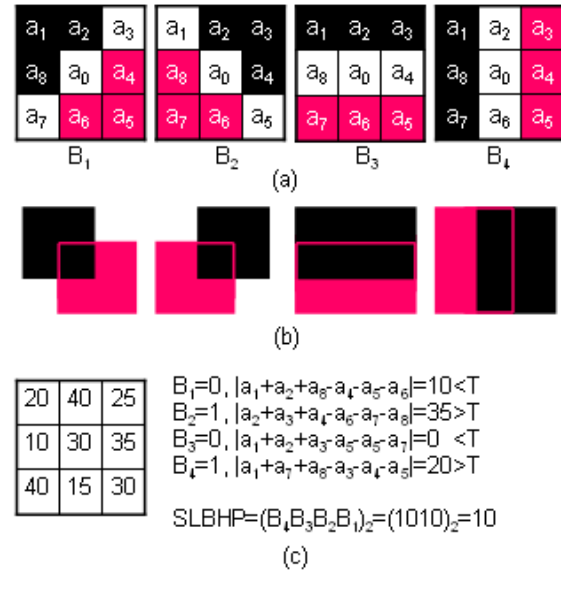
Fig. 4. An example of SLBHP. (a) Four Haar features; (b) corresponding Haar features with overlapping; (c) an example to compute SLBHP values.